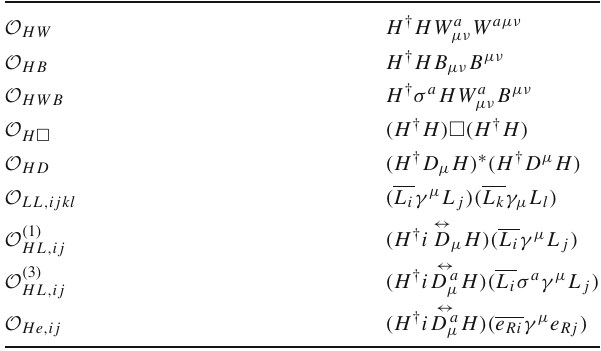
Table 2 Dimension-6 SMEFT operators in the Warsaw basis [73] which enter the correction to the Higgsstrahlung cross section.